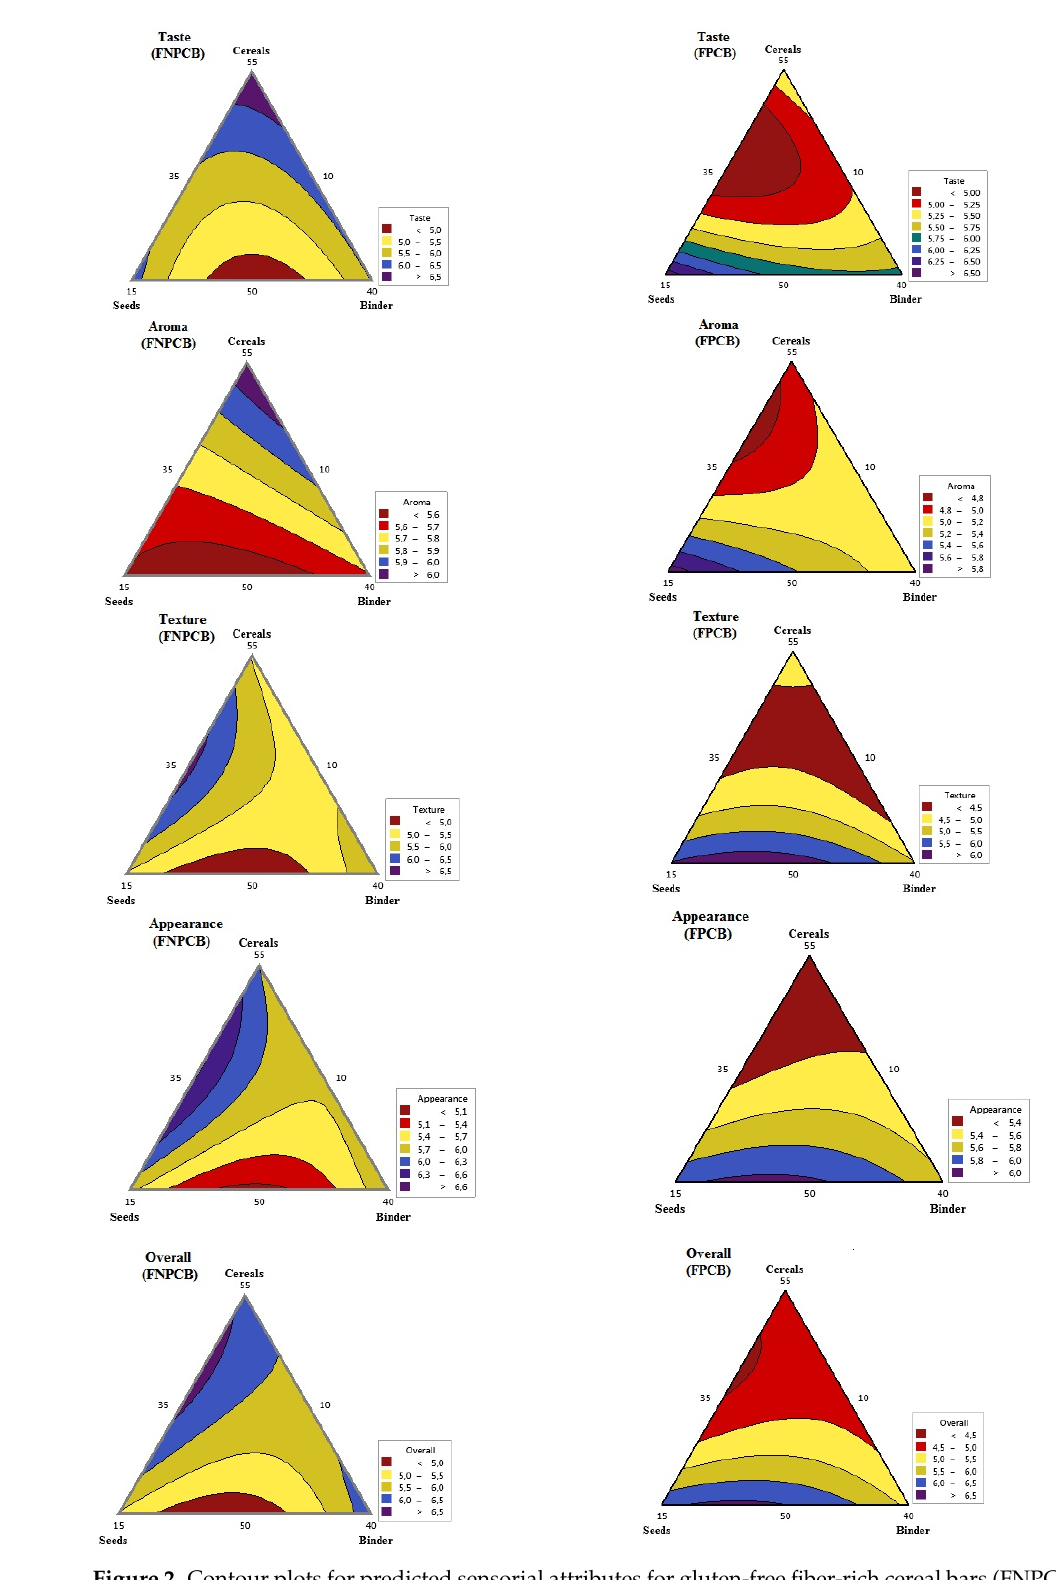
(FNPCB: Fiber-rich Non-Puffed Cereal Bars; FPCB: Fiber-rich Puffed Cereal Bars). Fiber-rich Non-Puffed Cereal Bars; FPCB: Fiber-rich Puffed Cereal Bars).